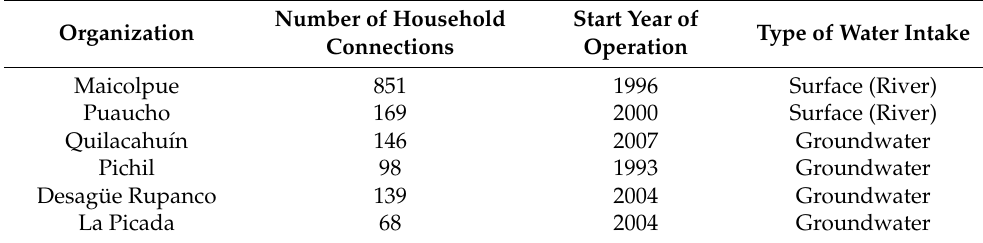
Table 1. Operation characteristics of the selected organizations. Organizations vary in the number of household connections, starting year of operation, and type of water